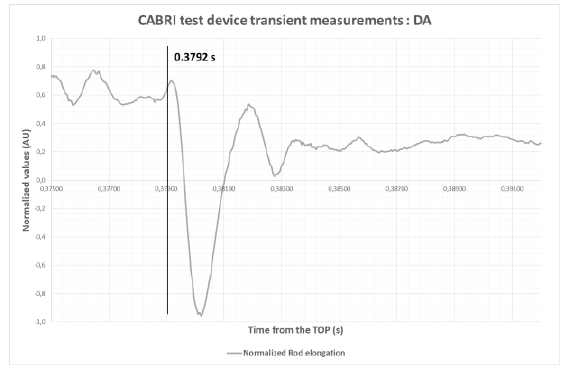
Fig. 5. Test device measurements of interest: elongation (DA).